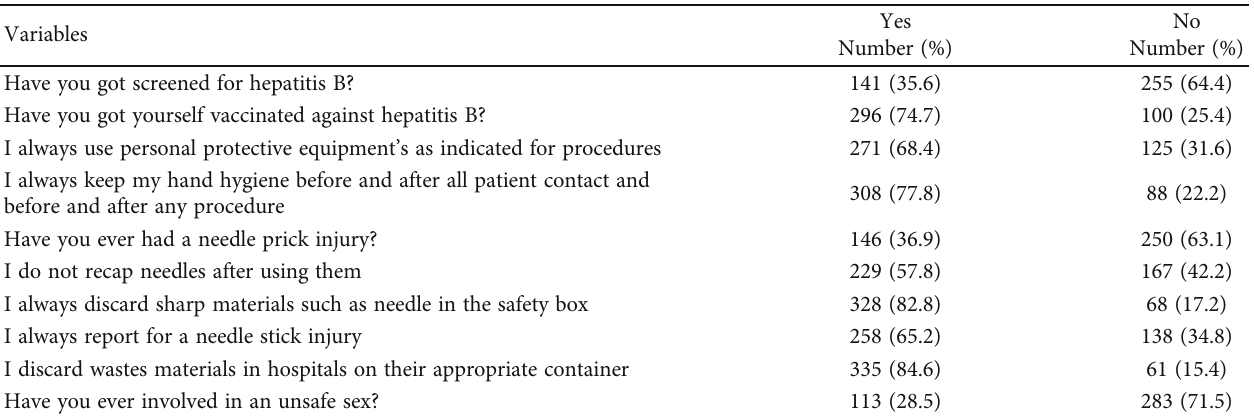
Table 4: Frequency distribution of students ’ practice score regarding HBV infection prevention at Hawassa University College of Medicine and Health Sciences, Hawassa, Ethiopia, 2021 ( n = 396 ).